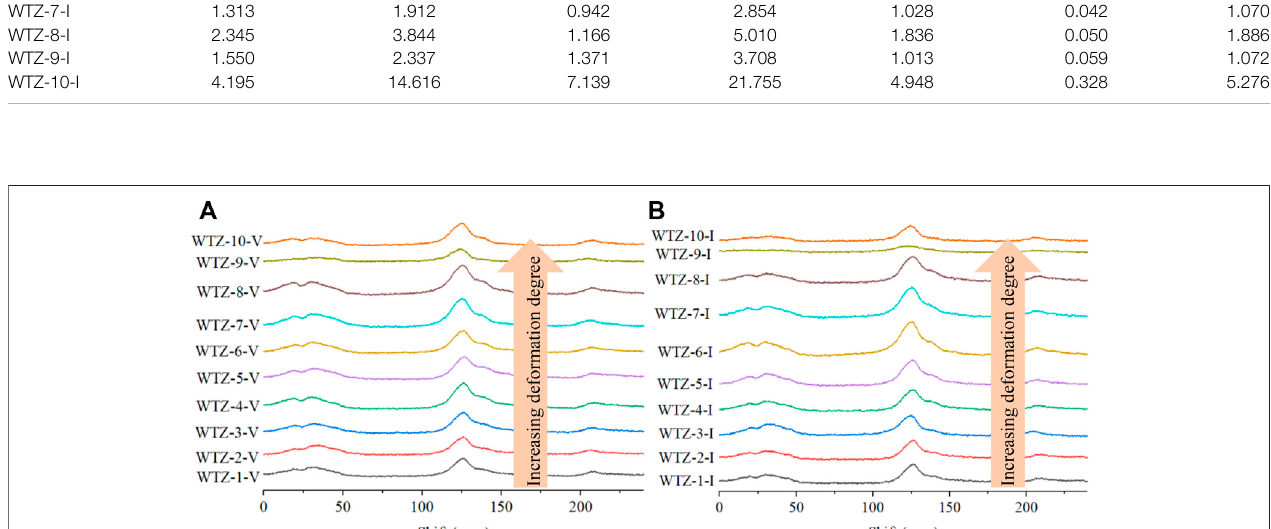
Frontiers in Earth Science |